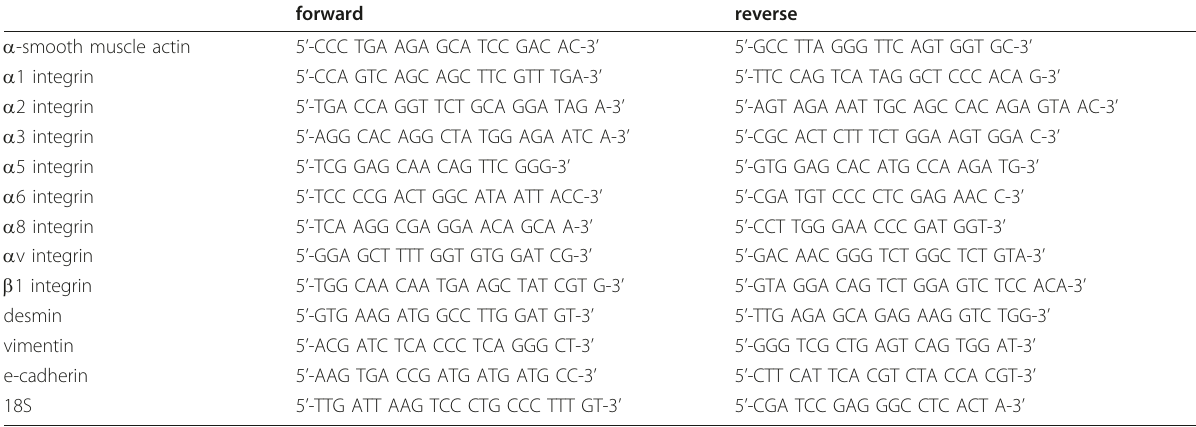
Table 1 Primer pairs for Sybr green analysis